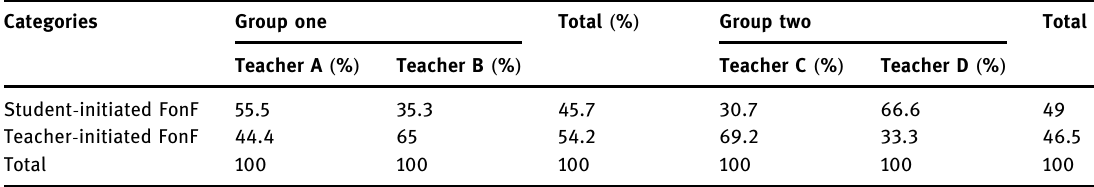
Table 2: Frequency of student - initiated and teacher - initiated FFEs in two groups